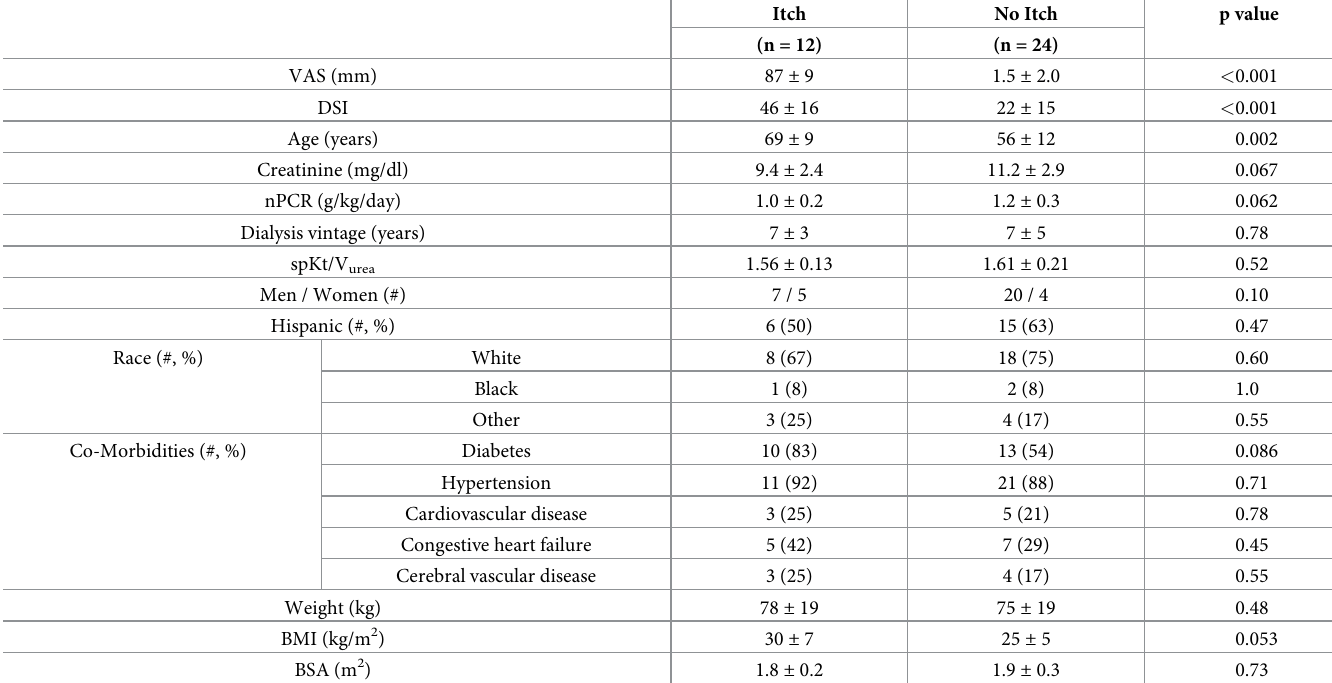
Table 1. Characteristics of Itch and No Itch HD